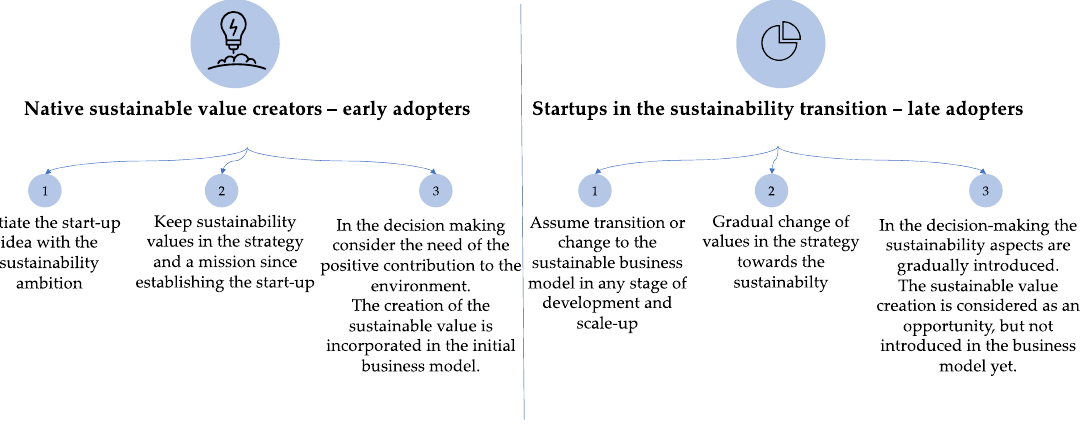
Figure 5. Types of incubated start-ups, depending on sustainability ambition and strategy (source: the authors).